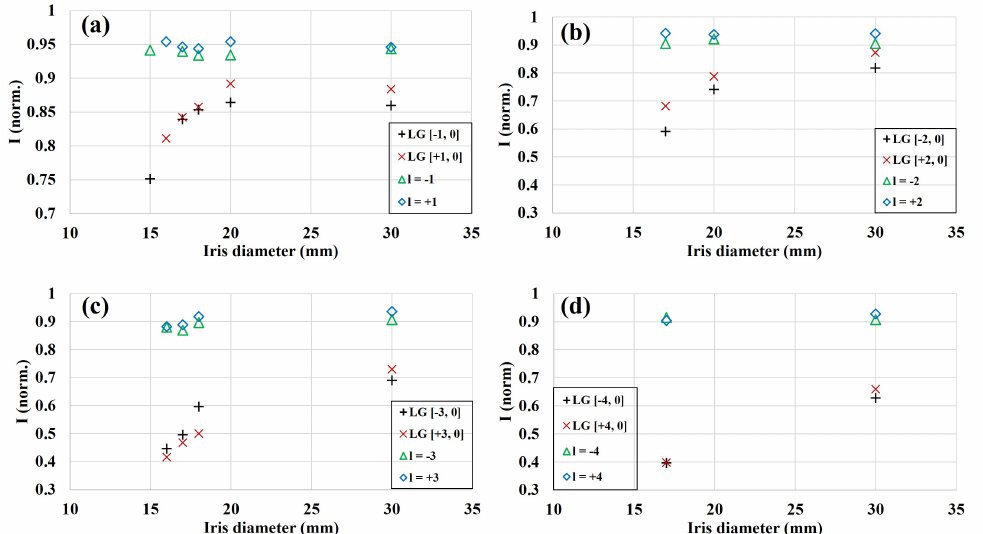
Figure 8. Effect of radial clipping on the modal content. The OAM purity and LG (cid:96) ,0 mode contri- bution for various iris diameters: ( a ) (cid:96) = ± 1, ( b ) (cid:96) = ± 2, ( c ) (cid:96) = ± 3, and ( d ) (cid:96) = ± 4. The 30 mm aperture diameter corresponds to a fully open iris. The contribution to desired OAM order only minutely varies with aperture size, whereas the energy contained in p = 0 radial mode shows a large reduction for the smaller diameter. This behavior is consistent for all the